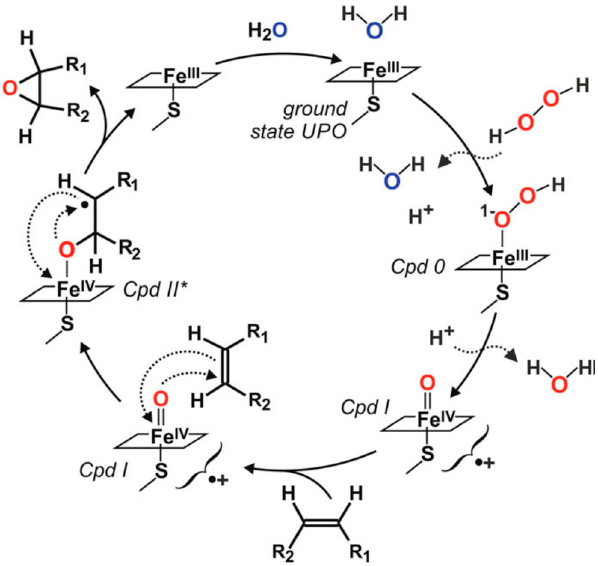
Figure 1. Proposed epoxidation cycle of UPO, showing activation of the ground state enzyme by H 2 O 2 , through hydroperoxo compound-0 (Cpd 0), to form reactive Cpd I able to epoxidize double bonds via a transient oxoferryl–substrate radical complex (Cpd II*). Reprinted from Ref. [19], 2020, Academic Press.